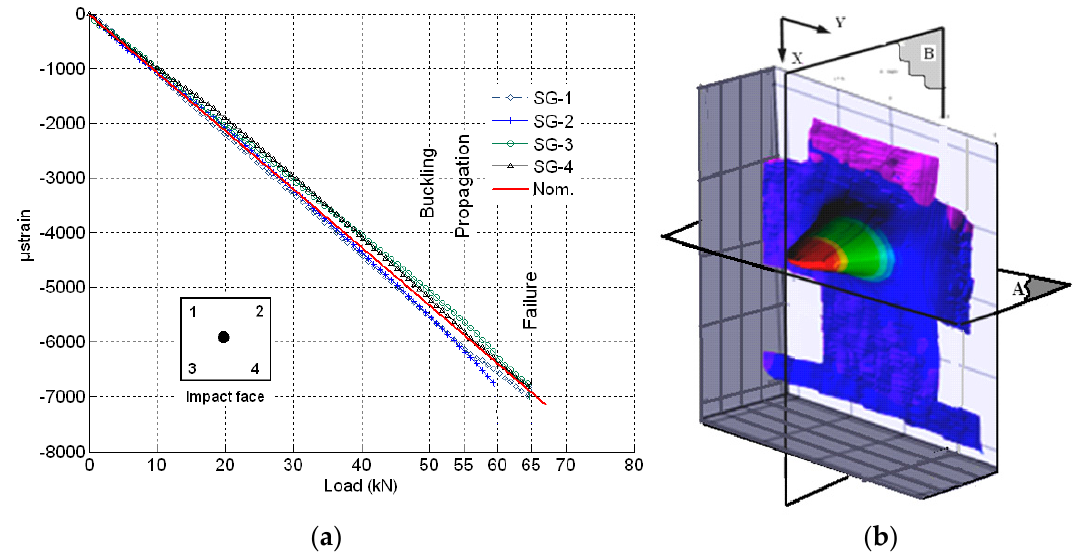
Figure 15. ( a ) Strain measurements for impacted face of the specimen with [( ∓ 45 C ) 2 ,(90 C ,90 G ) 4 ,( ∓ 45 C ) 2 ] faces. ( b ) Out-of- plane displacements for specimen with [( ∓ 45 C ) 2 ,(90 C ,90 G ) 4 ,( ∓ 45 C ) 2 ] faces at 65 kN (A represents the cutting plane parallel to y direction, B represents the cutting plane parallel to x direction).